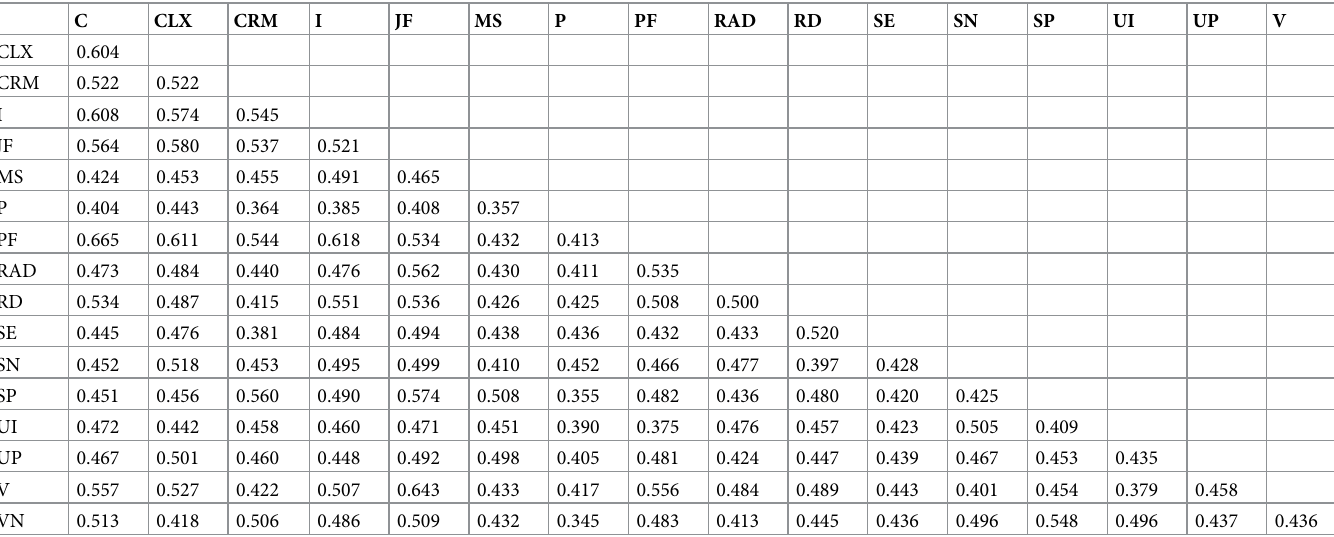
Table 4. HTMT ratio